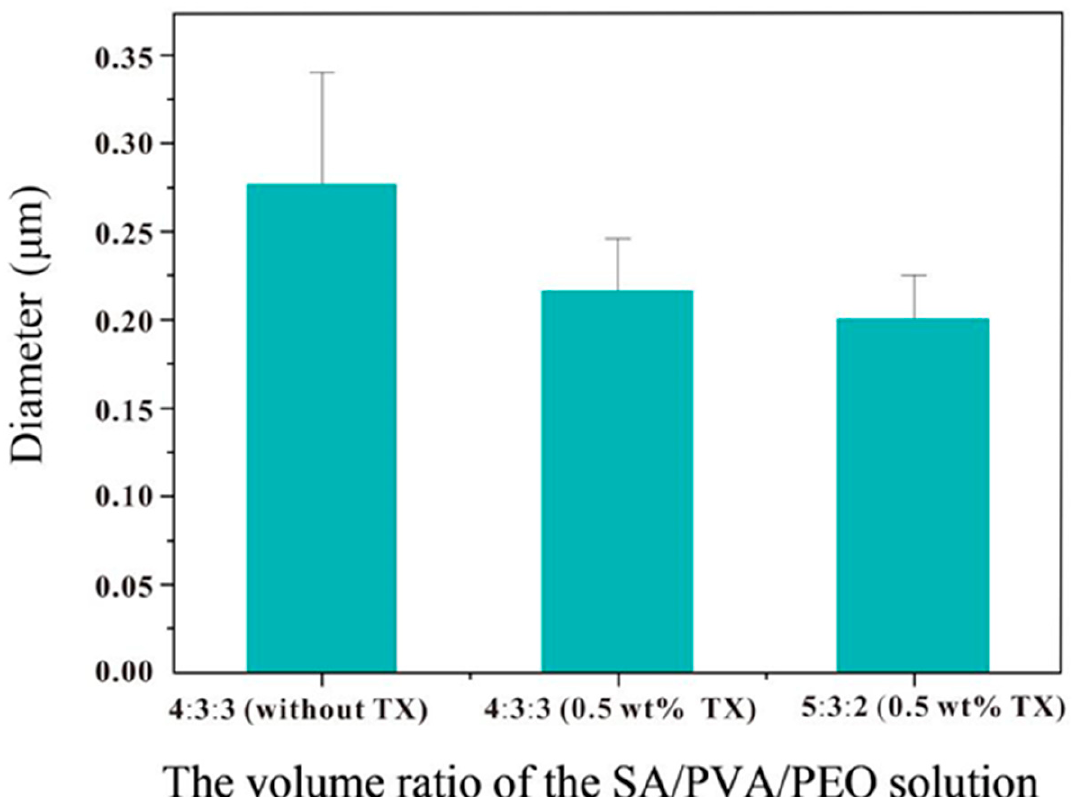
Figure 4. Average diameter distribution of three types of MFMs (TX: Triton X-100) .